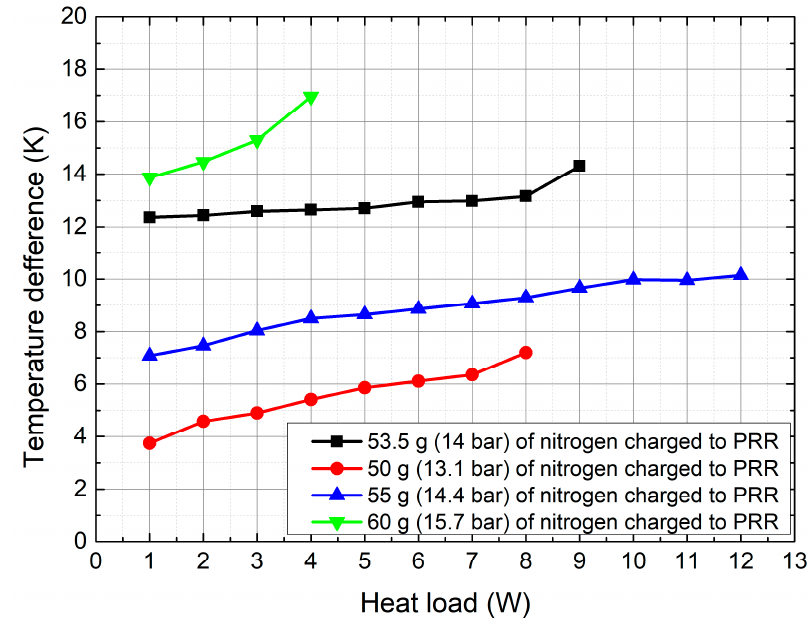
Figure 13. Temperature di ff erence of the main evaporator and condenser according to the heat load.